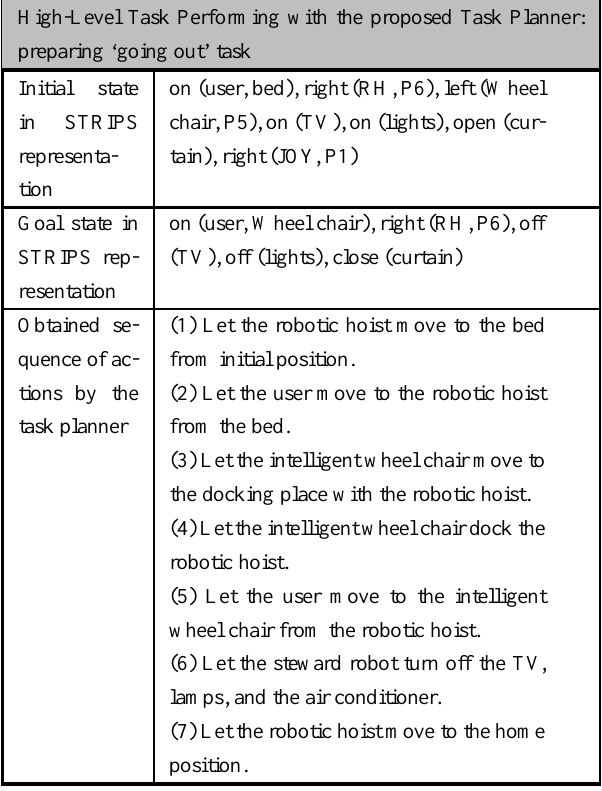
Table 2. Example of task planning High-Level Task Performing with the proposed Task Planner: preparing ‘going out’ task